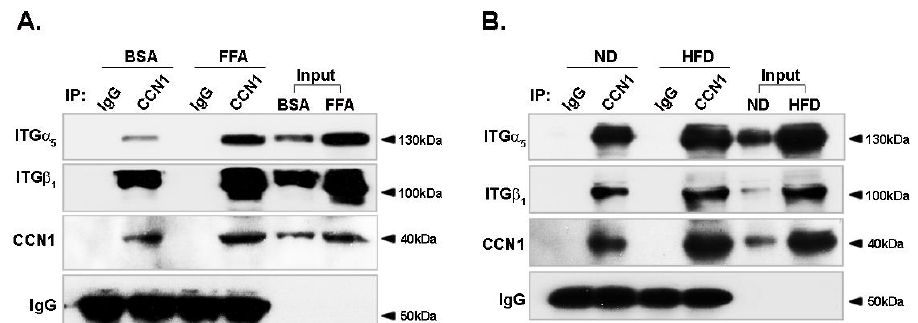
Figure 5. Effects of FFA on the binding of CCN1 to integrin a 5 β 1 . ( A ) Immunoblotting (IB; integrins α 5 and β 1 ) of whole cell lysates (input) and immunoprecipitates (IP: CCN1) from LO2 hepatocytes, with or without FFA (1 mM) treatment for 24 h. The immunoblots shown are representative of three independent experiments. ( B ) IB (integrins α 5 and β 1 ) of whole lysates (input) and IP (CCN1) from livers of db/m and db/db mice (8 weeks old). ITG α 5 : integrin α 5 ; ITG β 1 : integrin β 1